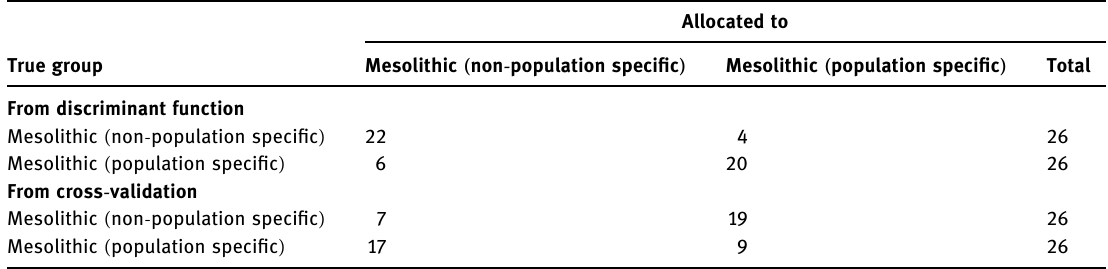
Table A7: DFA with cross - validation of the non - population - speci fi c reconstructed Mesolithic sample vs the population - speci fi c reconstructed Mesolithic sample ( see details about reconstruction parameters in Materials and Methods